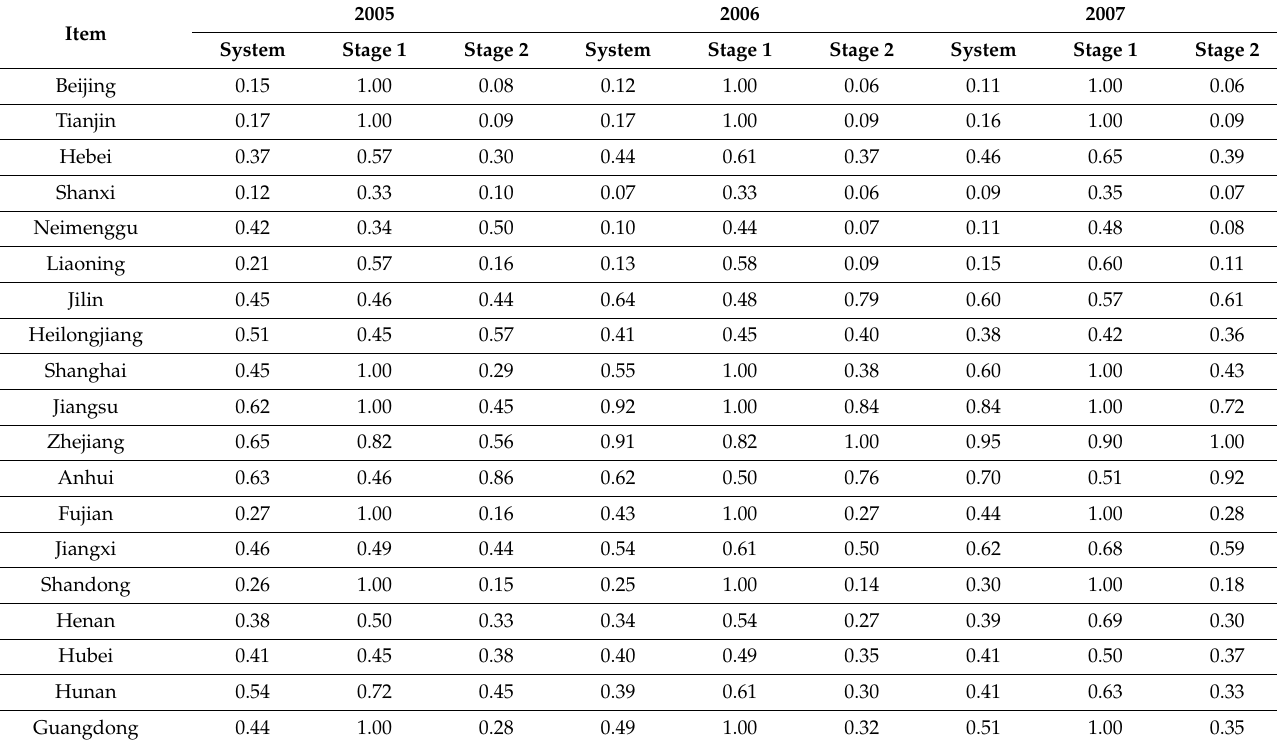
Table A2. System and process efficiencies during